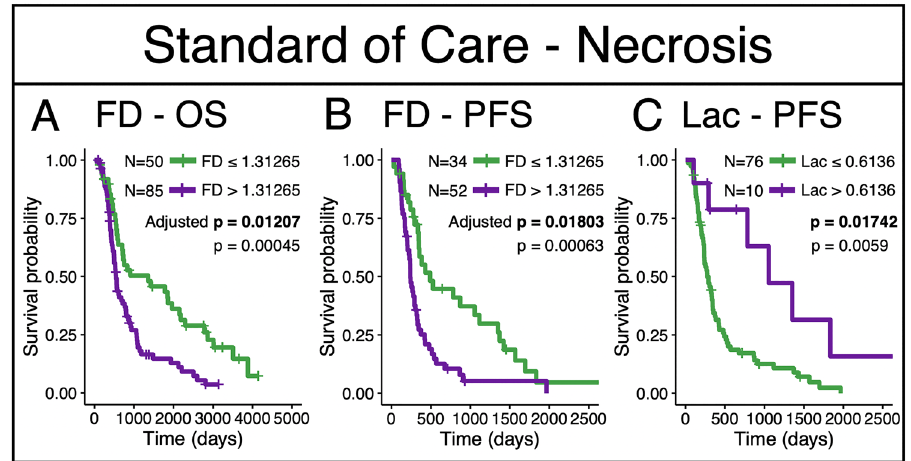
Figure 3. Fractal dimension and lacunarity cutoffs that significantly distinguish survival amongst patients confirmed to have received the current standard of care. ( A ) Fractal dimension of necrosis regions significantly distinguished OS. ( B ) Fractal dimension of necrosis regions significantly distinguished PFS. ( C ) Lacunarity significantly distinguished PFS. All three results remained significant with adjustment. Adjusted p values shown in